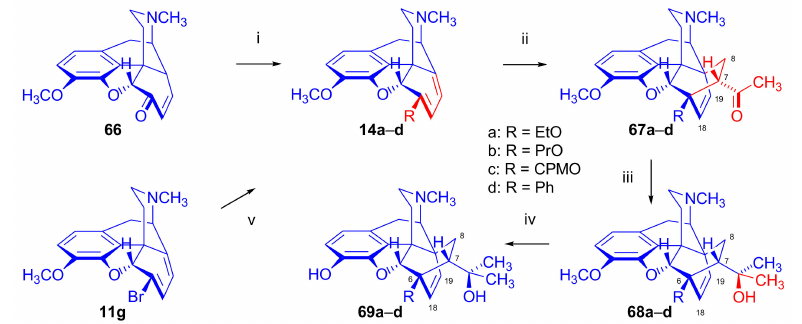
Figure 21. Synthesis of 6- O -substituted-20-methylorvinol derivatives. Reagents and conditions : (i): ROH, p -toluenesulfonic acid, benzene, 3 h, reflux, (ii): PhB(OH) 2 , Pd(PPh 3 ) 4 , Ba(OH) 2 · 8H 2 O, (iii): methyl vinyl ketone, reflux, 4 h, (iv): methylmagnesium bromide, THF, and (v): KOH, ethylene glycol-water, reflux, 8 h.